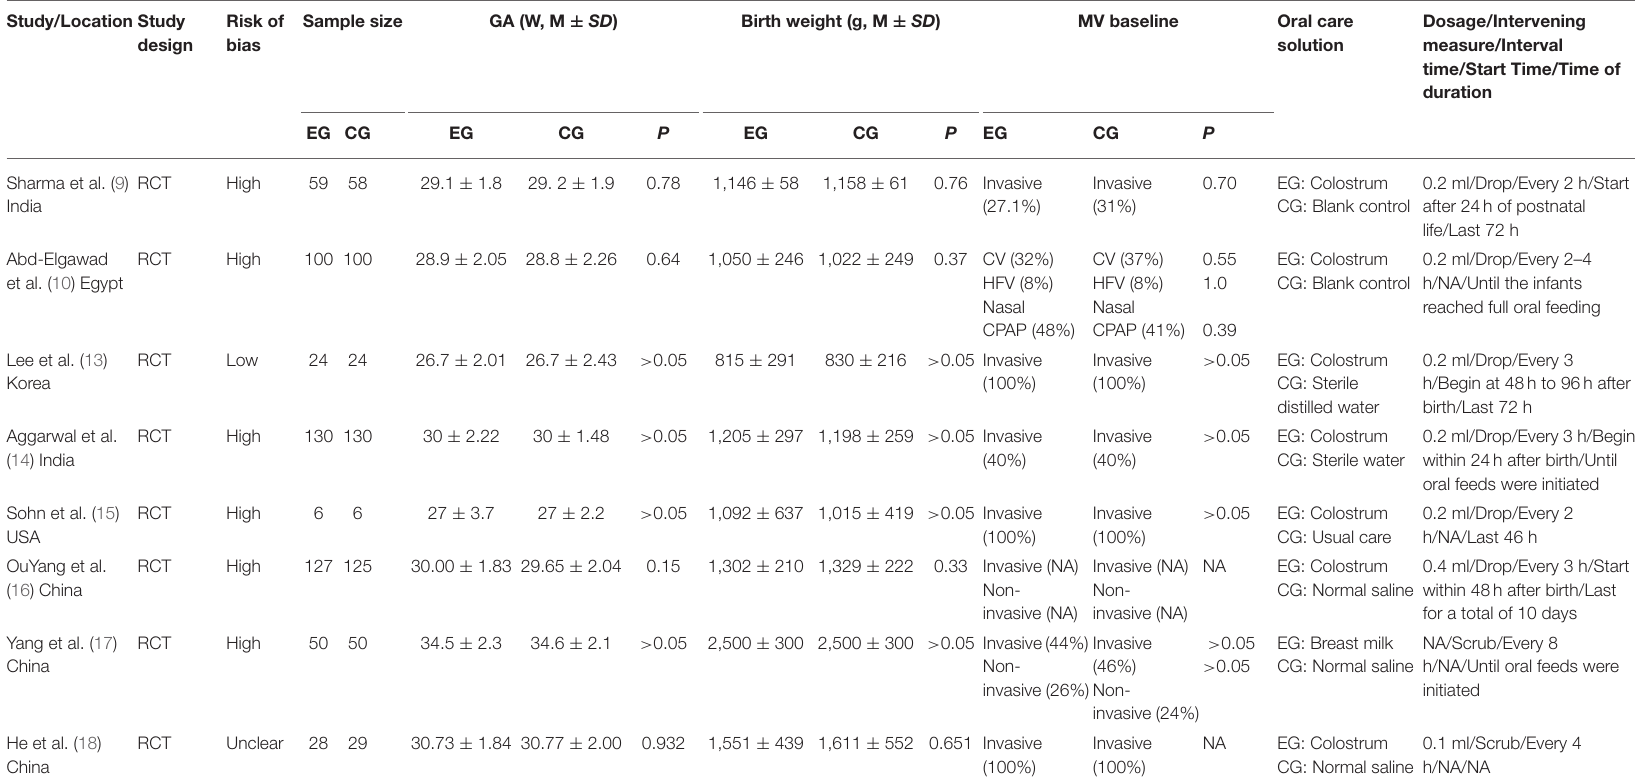
TABLE 1 | Characteristics of the studies included in the meta-analysis.